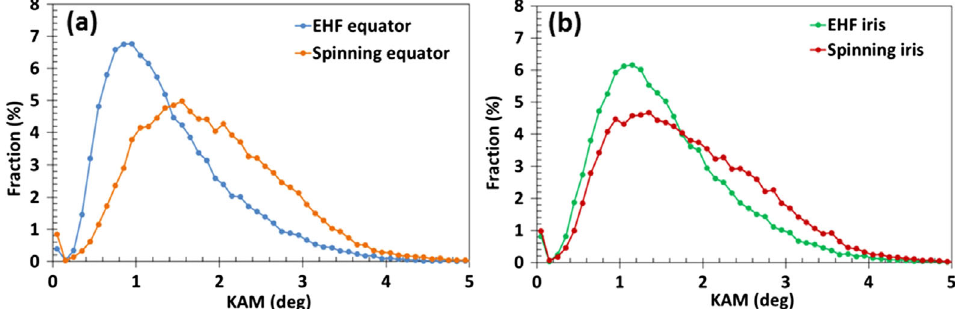
FIG. 16. Local misorientation distribution for specimens extracted from half-cells formed by EHF and spinning: (a) specimens obtained from equator; (b) specimens obtained from iris.